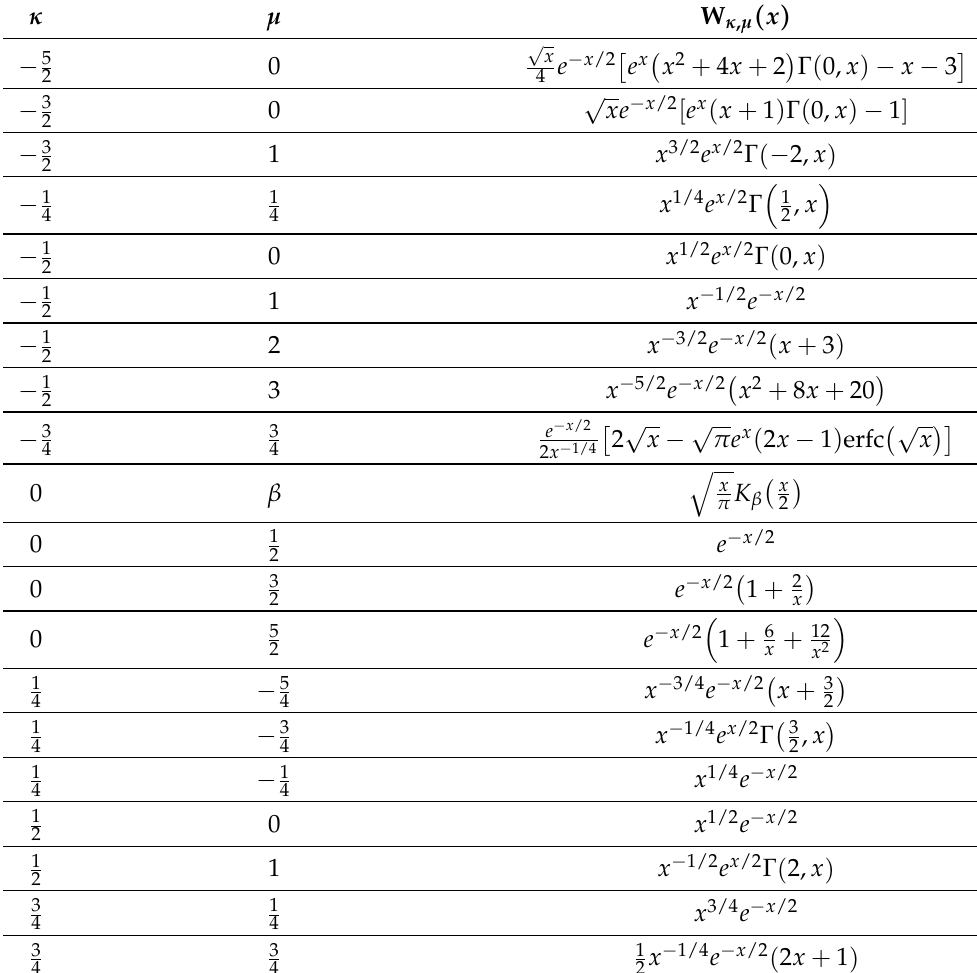
Table A10. The Whittaker functions W κ , µ derived for some values of parameters κ and µ by using (18).